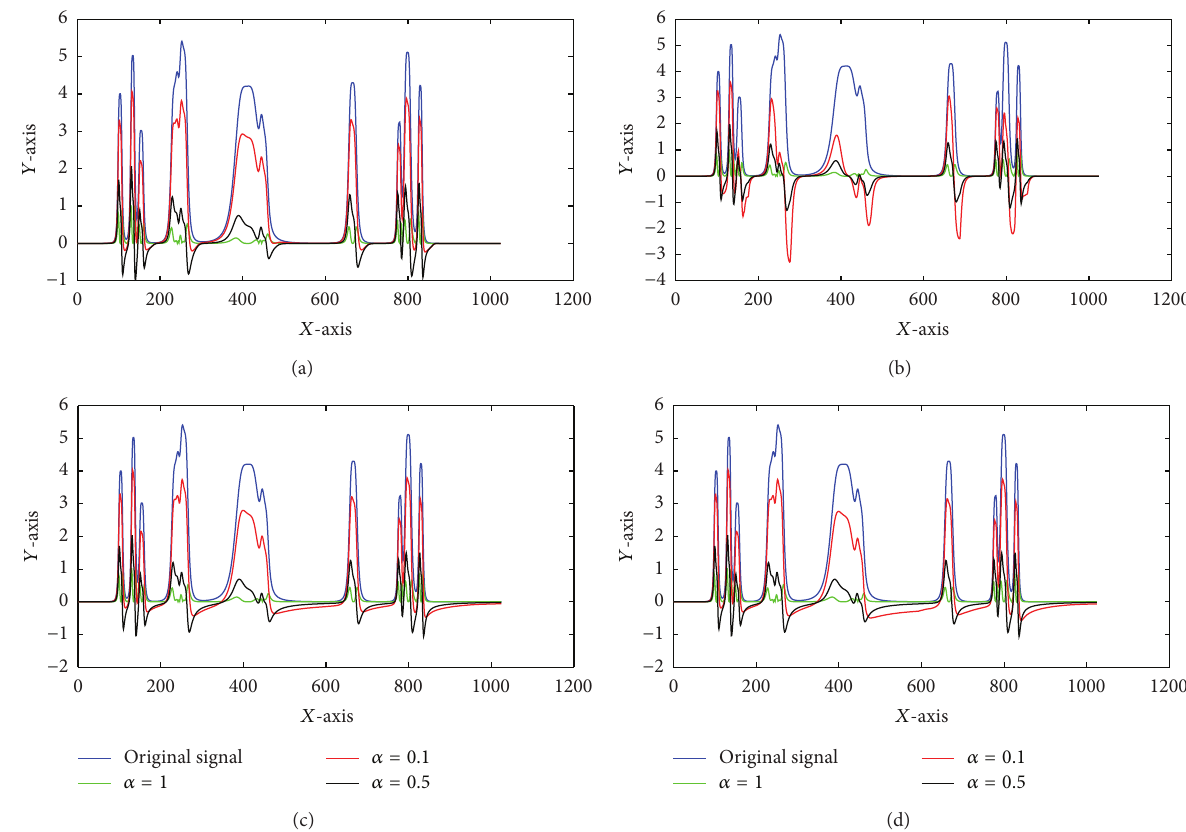
Figure 3: The original signal (bumps with 1024 samples, blue line), its fractional derivatives of truncated G-L with different fractional orders ((a) and (c)), and its fractional derivatives of the new method with different fractional orders ((b) and (d)), where the support length of (a) and (b) is 30 and the support length of (c) and (d) is